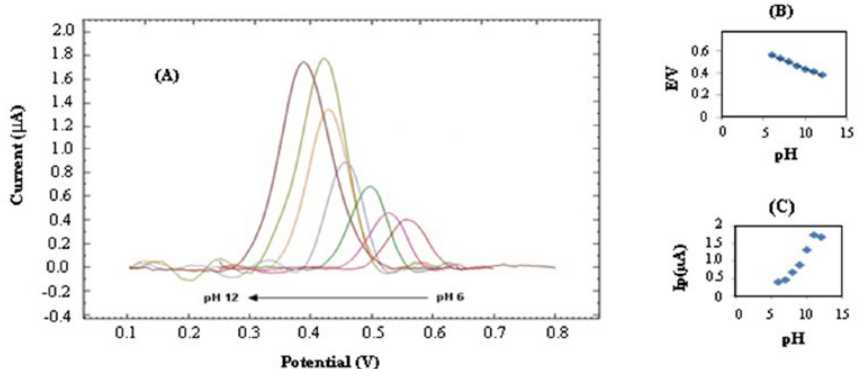
Fig. 4 . (A) Differential pulse voltammogram of 0.695 µM insulin in BRBS and KCl (0.2 M) in different pH (B) potential versus pH, (C) current versus pH.